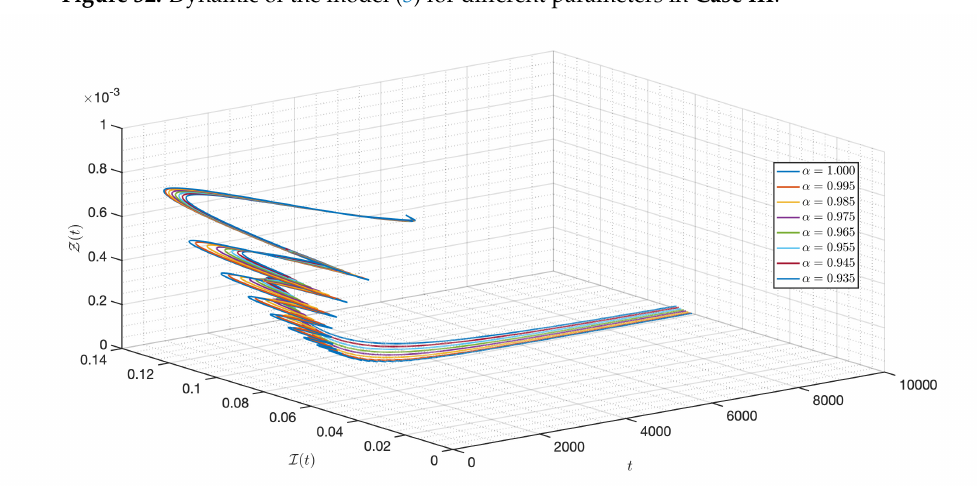
Figure 32. Dynamic of the model (3) for different parameters in Case III .